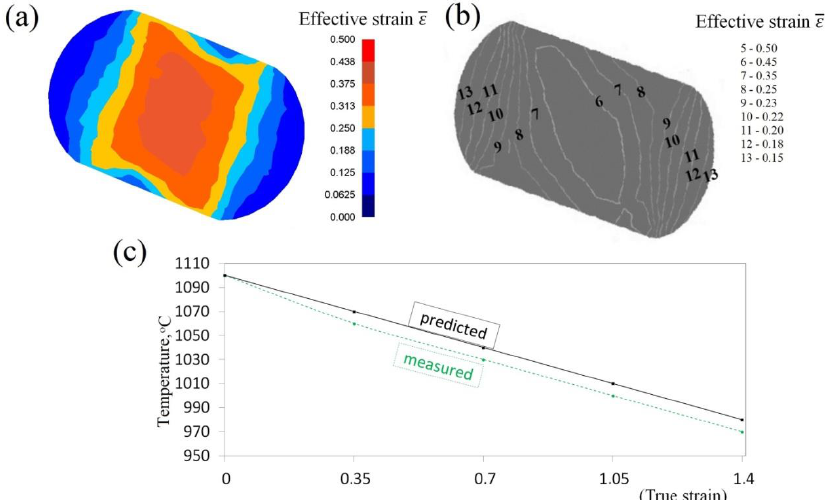
Figure 16. Comparison of theoretical and experimental results after the cogging process in anvils with skew working surfaces: theoretical ( a ) and experimental ( b ) distributions of effective strain (l w = 0.75, ε h = 0.35); ( c ) temperature on the surface of the specimens.